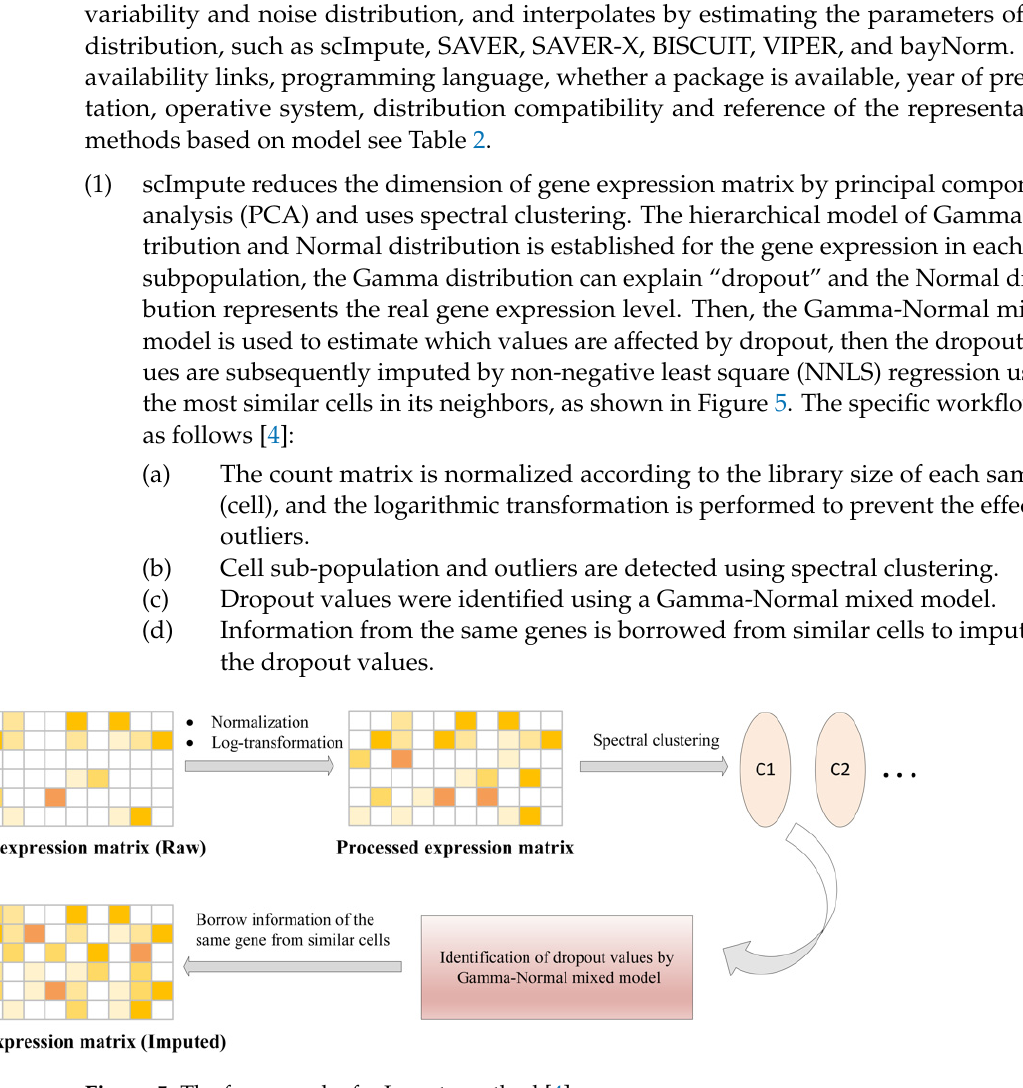
Figure 4. The four classification of imputation method for the detailed division of Bayesian and non-Bayesian methods.